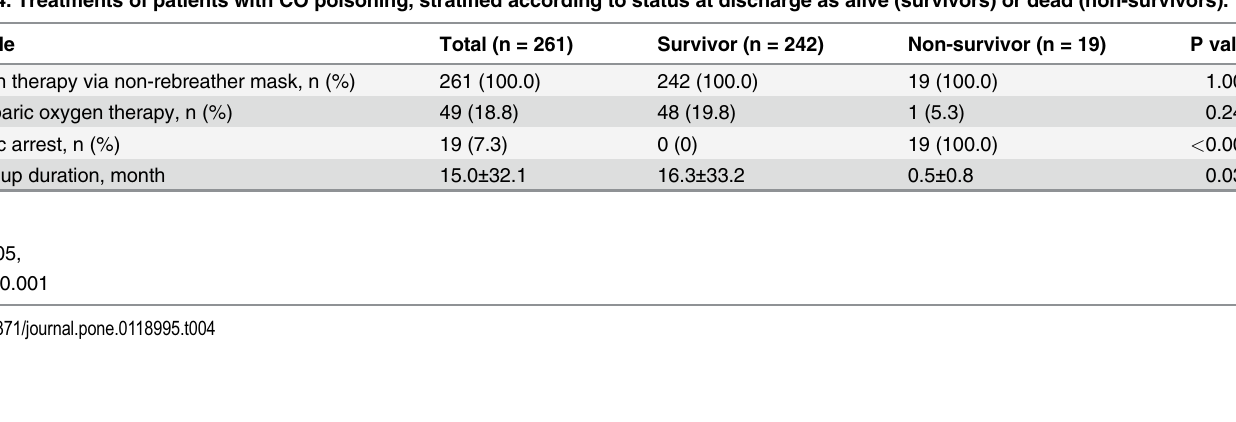
Table 4. Treatments of patients with CO poisoning, strati fi ed according to status at discharge as alive (survivors) or dead